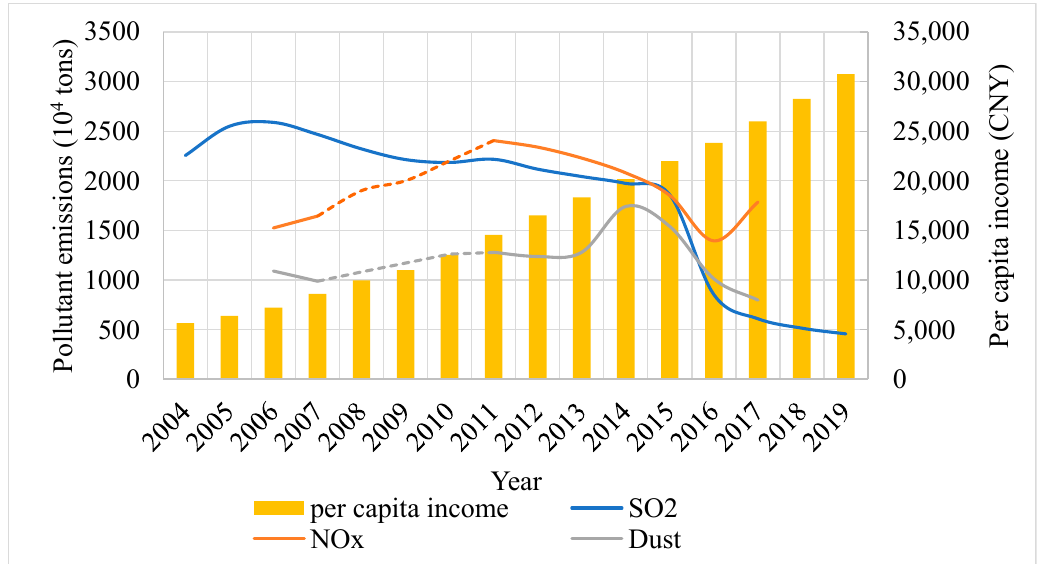
Figure 1. The coal-relevant pollution and per capita income of China (2004–2019).